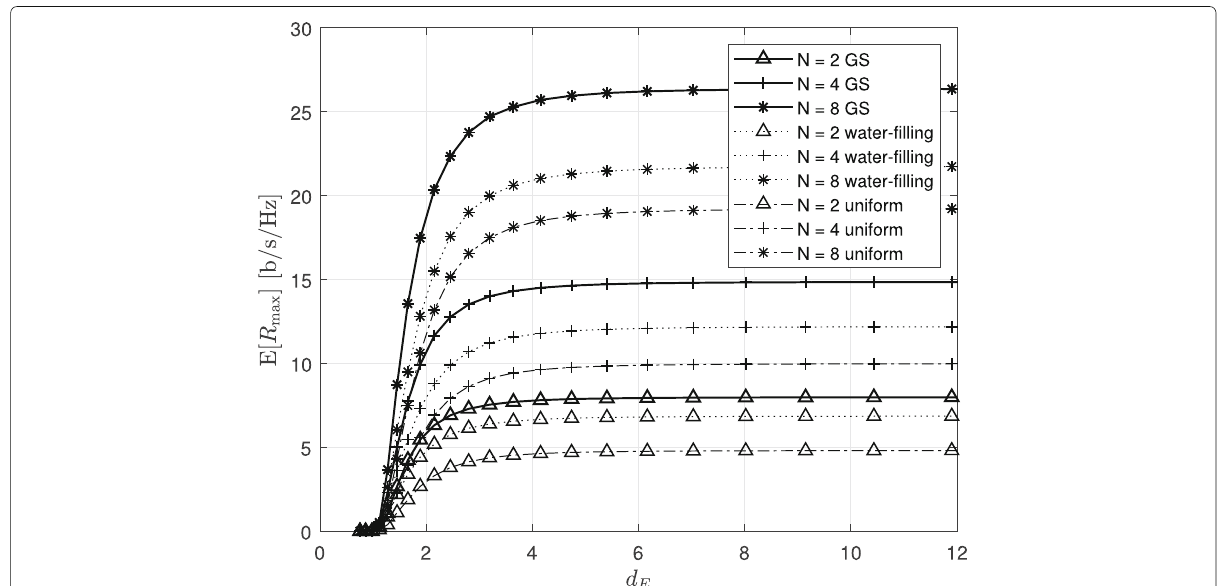
Fig. 12 Average maximum outage secrecy rate as a function of d E , with infinite-length coding ( m = 4096) and Gaussian constellation, obtained using GS power allocation, water-filling, and uniform power allocation